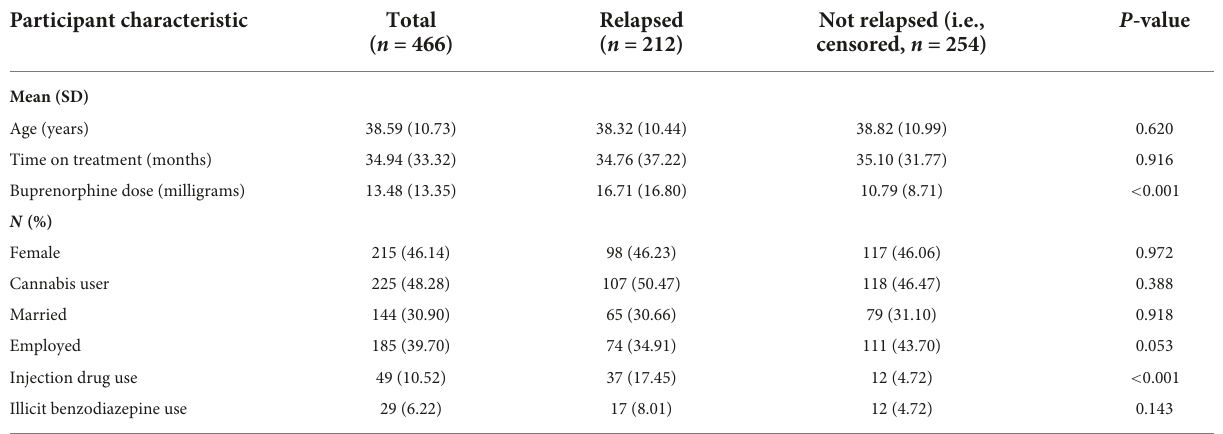
TABLE 1 Baseline participant characteristics.